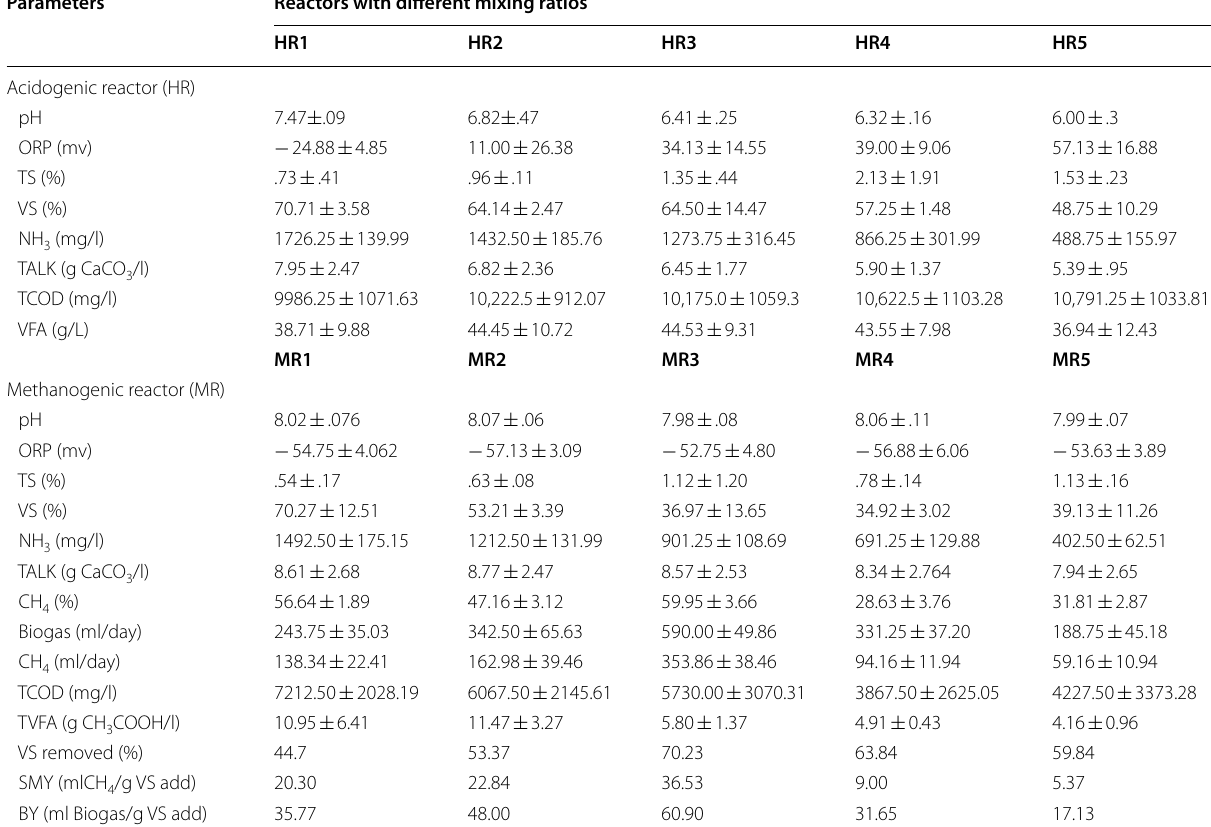
Table 5 Performance of acidogenic and methanogenic reactors (MR) with different mixing ratios Parameters Reactors with different mixing